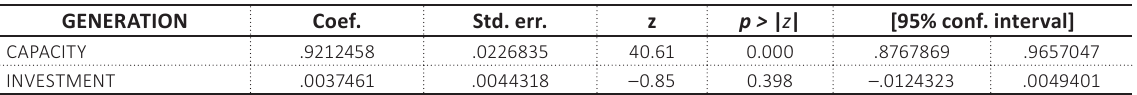
Table 2. SFA model